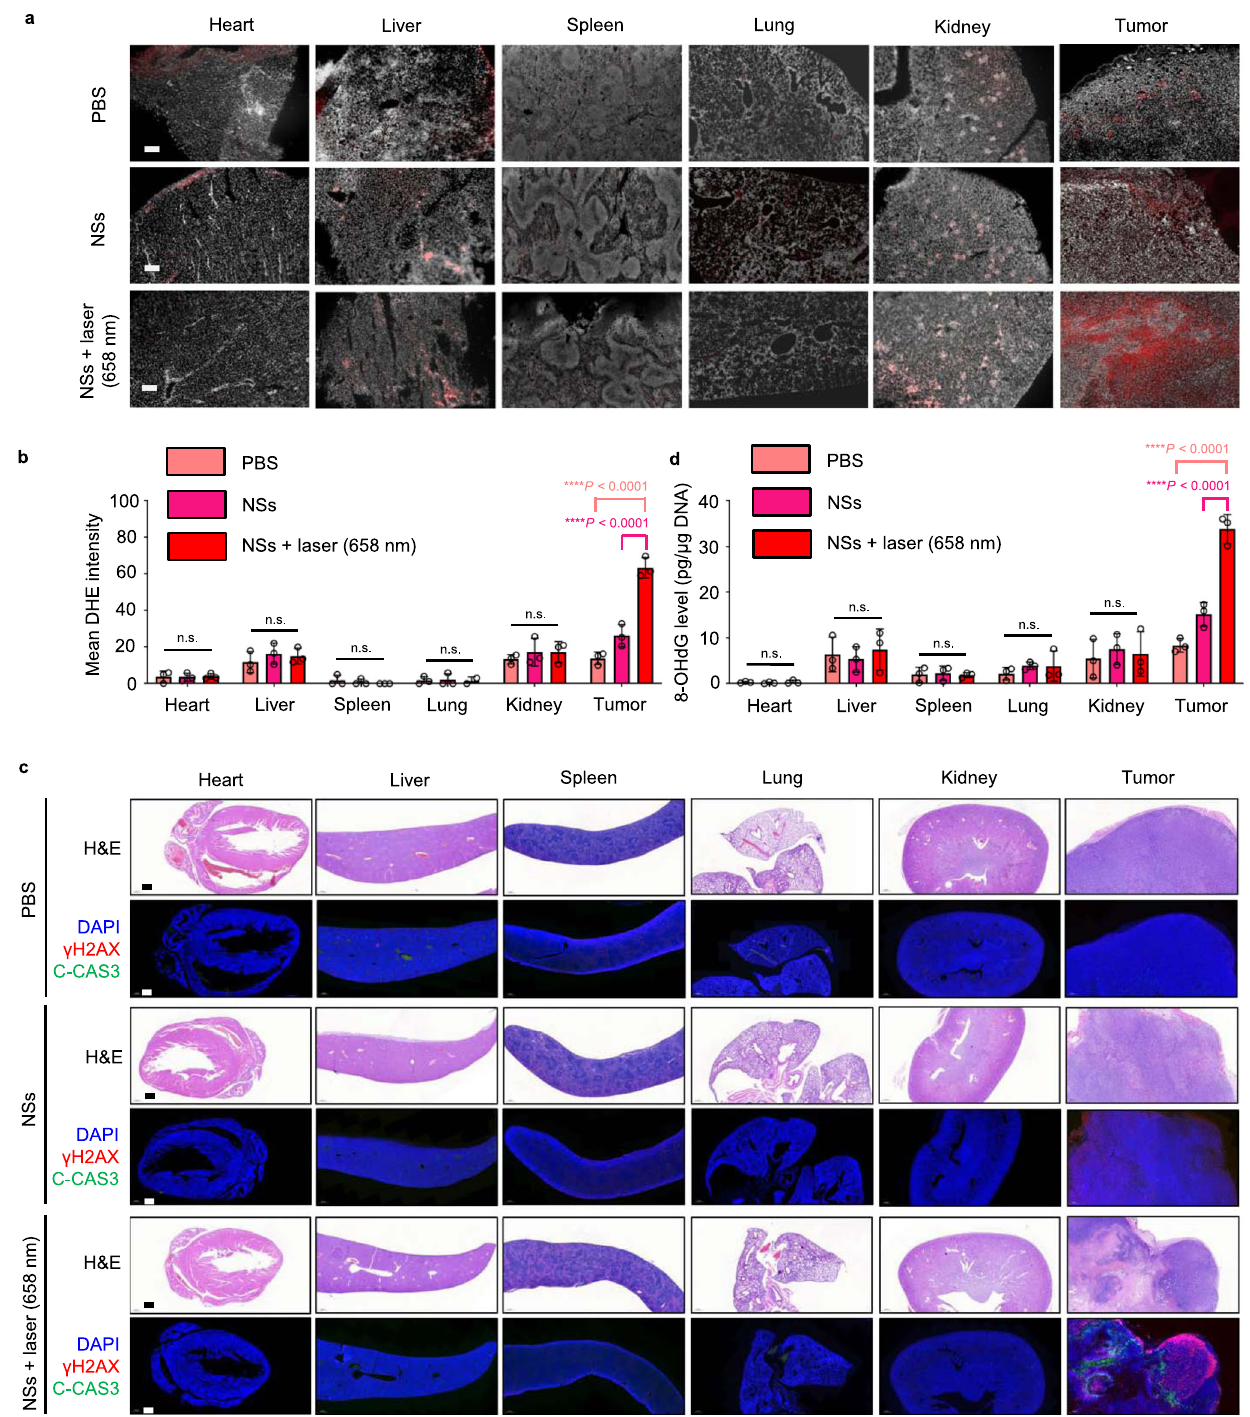
Fig. 9 In vivo toxicity. a In vivo ROS detection in the sections from major organs and tumors by dihydroethidium (DHE) via fl uorescence microscopy. The major organs and tumors were collected from the HepG2 xenograft-tumor-bearing mice after different treatments with PBS, NSs, or NSs + 658 nm NIR irradiation (irradiation was performed only within tumor areas). Scar bar = 200 µ m. b Quanti fi cation of the in vivo ROS signals from the major organs and tumors calculated from the section studies in ( a ). The data show mean ± s.d., n = 3 biologically independent mice, and signi fi cance was determined using a two-tailed t -test (**** P < 0.0001). c H&E staining and immuno fl uorescence (IF) staining in the sections from the major organs and tumors, which were collected from the HepG2 xenograft-tumor-bearing mice after different treatments with PBS, NSs, or NSs + 658 nm NIR irradiation (the irradiations were only performed within tumor areas). The nucleus was stained by DAPI (blue), damaged DNA was stained by γ H2AX foci (red), and apoptotic cells were stained by apoptosis marker C-CAS3 (green). Scar bar = 500 µ m. Three times each experiment was repeated independently with similar results. d In vivo DNA damage of the major organs and tumors after different treatments was measured by 8-OHdG assay. The data show mean ± s.d., n = 3 biologically independent mice, and signi fi cance was determined using a two-tailed t -test (**** P < 0.0001).